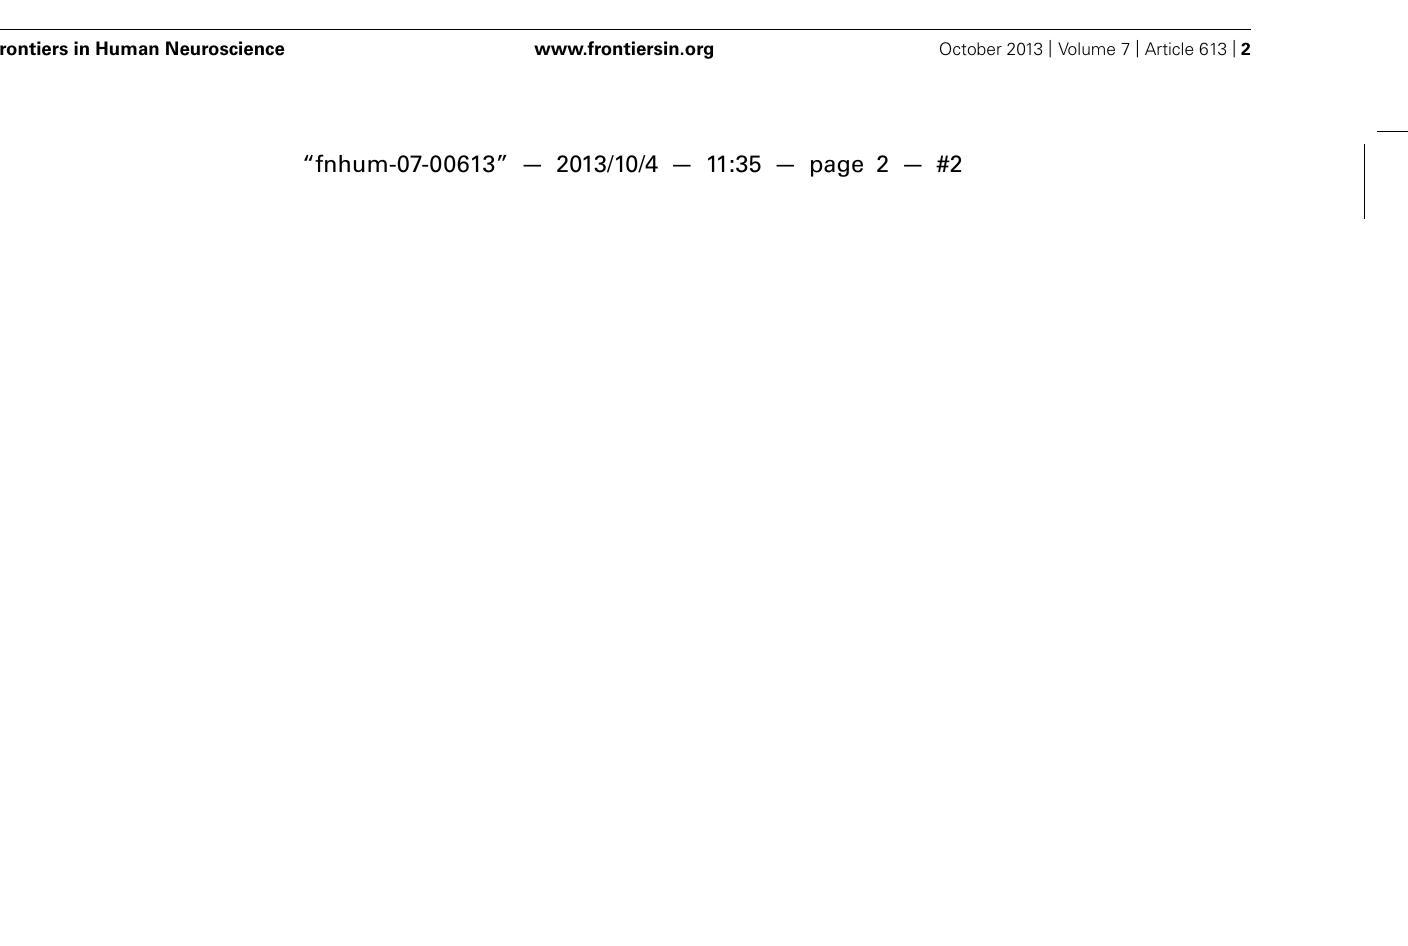
FIGURE 1 | Examining current distributions in the cortex . (A) The classic montage used by Nitsche and Paulus (2000) to modulate MEP size. (B) Finite element modeling of current distribution with the classic montage illustrates the broad swathes of cortex affected. (C) Voltage drops across membranes considered as resistors explain the mixture of